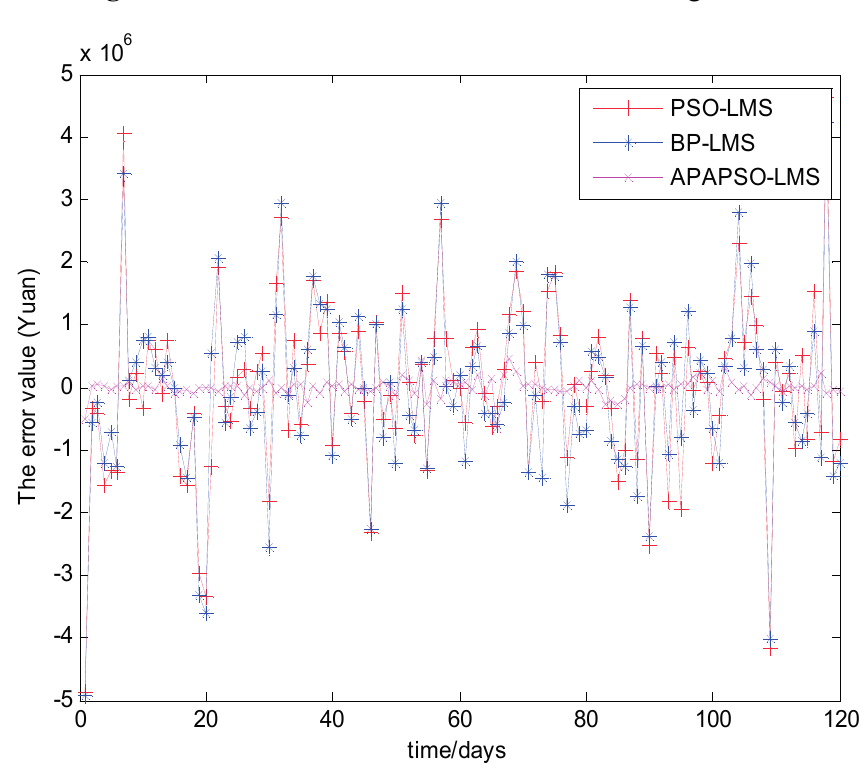
Figure 10. Comparison results of prediction